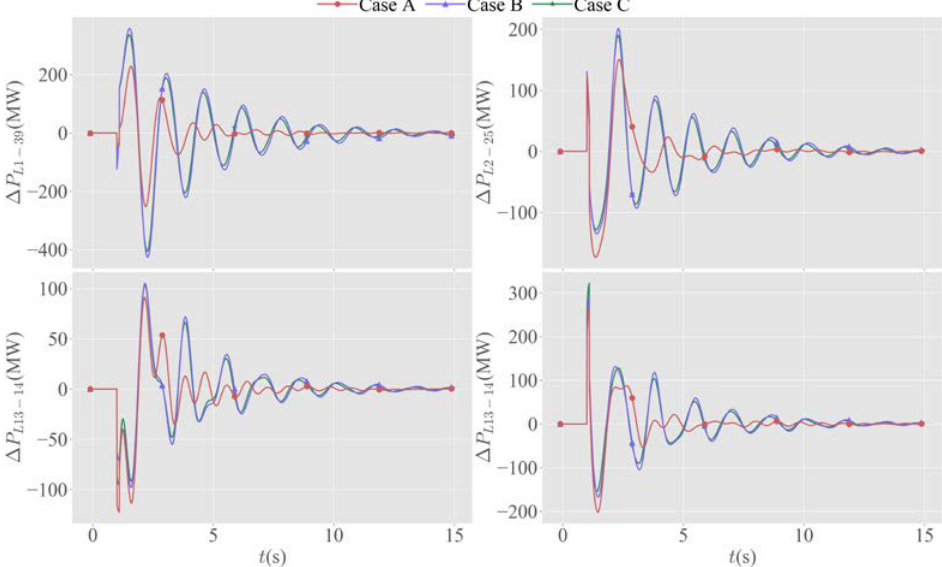
Figure 7. The transmission line power deviation with different HVDC locations. Table 3. Grid losses with different HVDC locations.